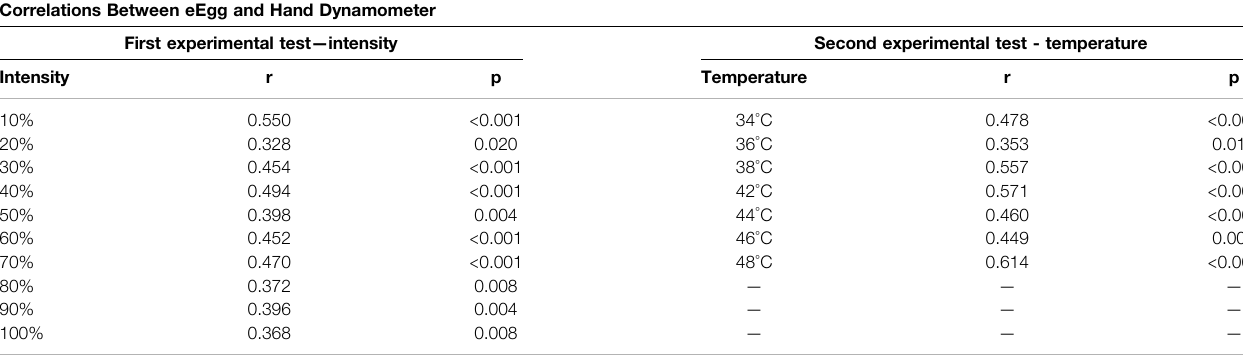
r = correlations coef fi cient according to Spearman; p -values are considered signi fi cant with p < 0.05.